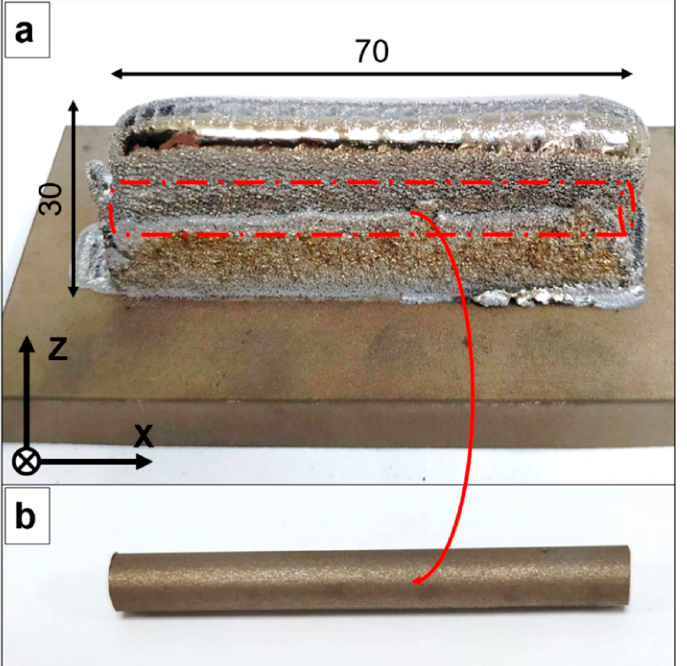
Figure 4. ( a ) Laser-deposited Ti-42Nb horizontal specimen. ( b ) Horizontal cylindrical sample. All dimensions are shown in mm.